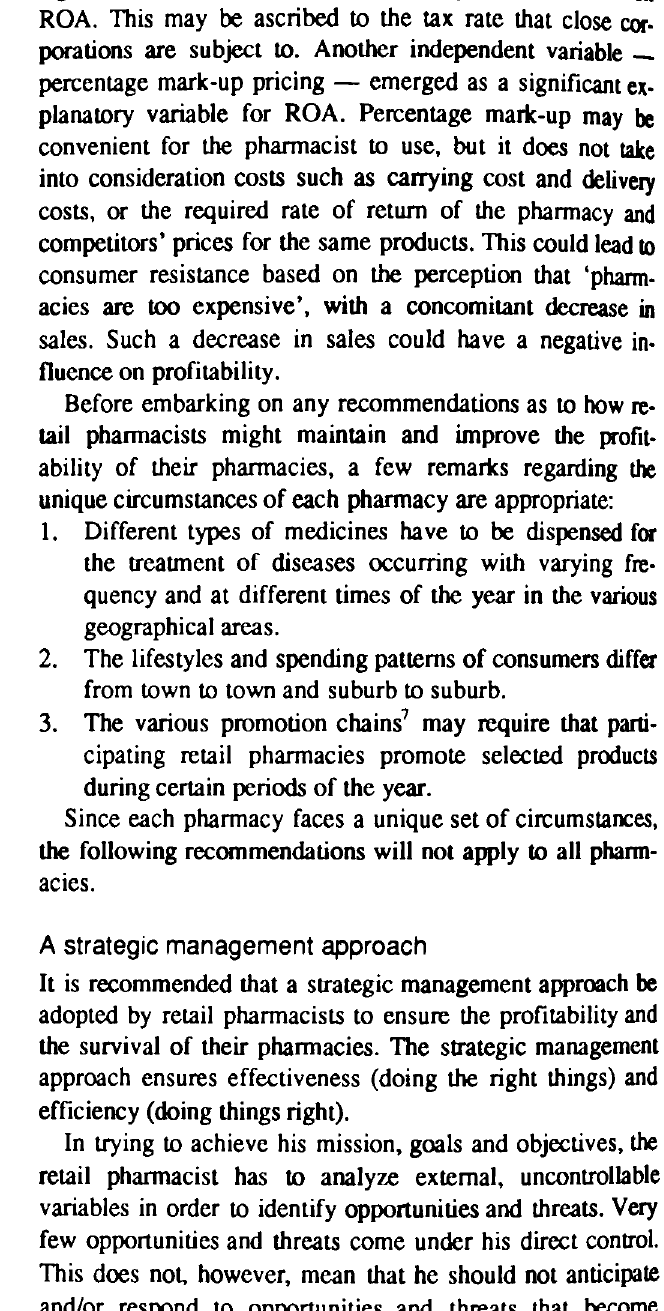
Table 6 Results of the regression model for ROA